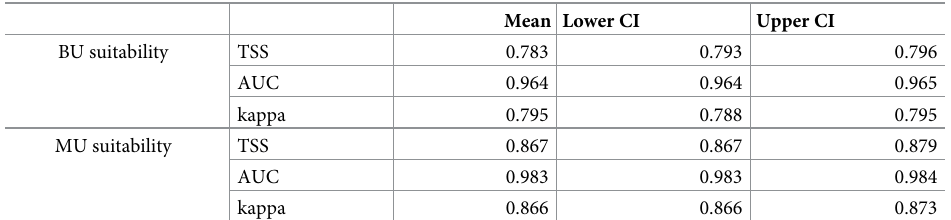
Table 1. Validation metrics for ensemble models for BU and M . ulcerans